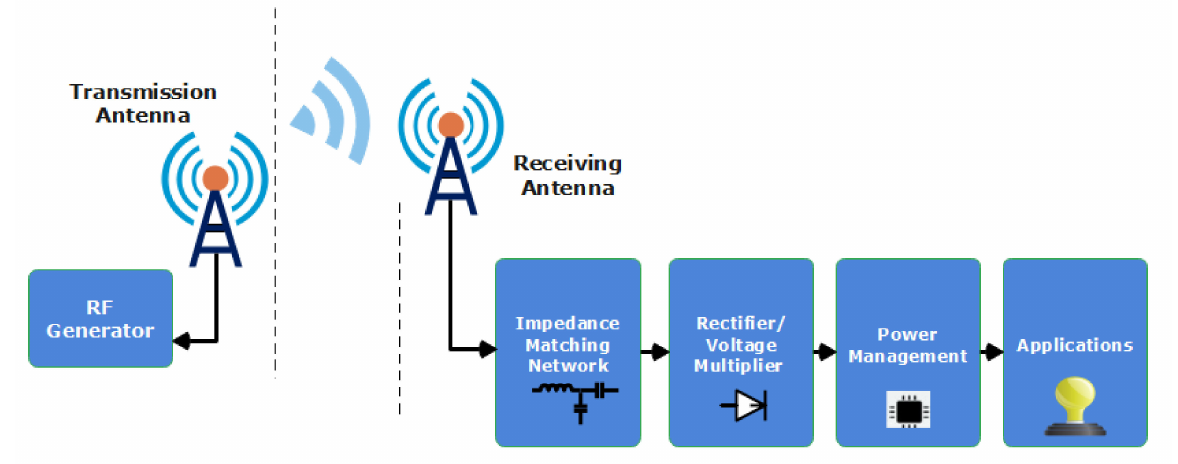
Figure 1. An RF energy harvesting systems conceptual block